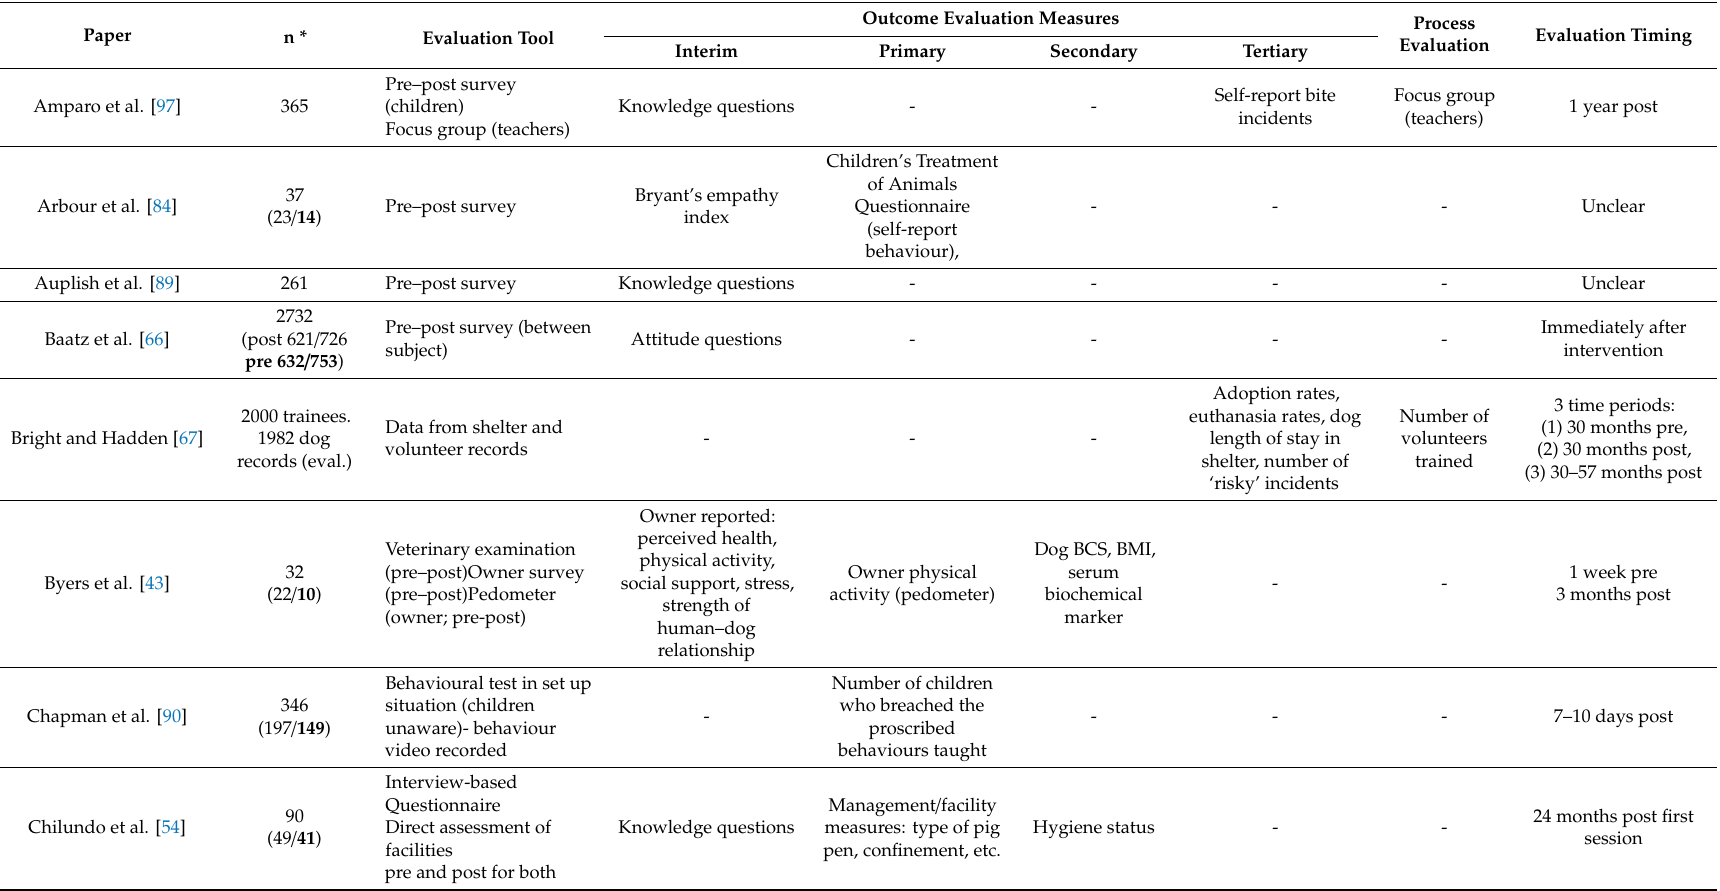
Table A3. Evaluation